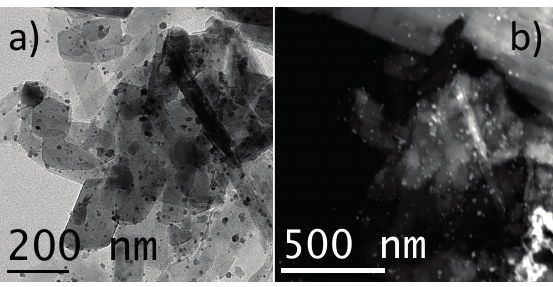
Figure 7. ( a ) Bright-field TEM and ( b ) STEM images corresponding to the AgNP distribution onto the zeolite